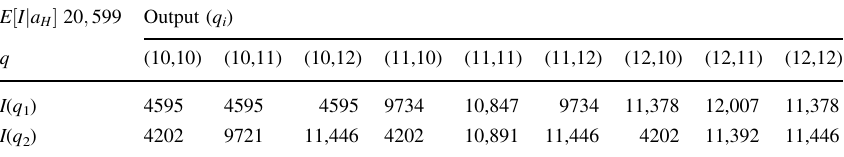
Table 4 Pay for performance using both divisions with transfer and adjusted outcome